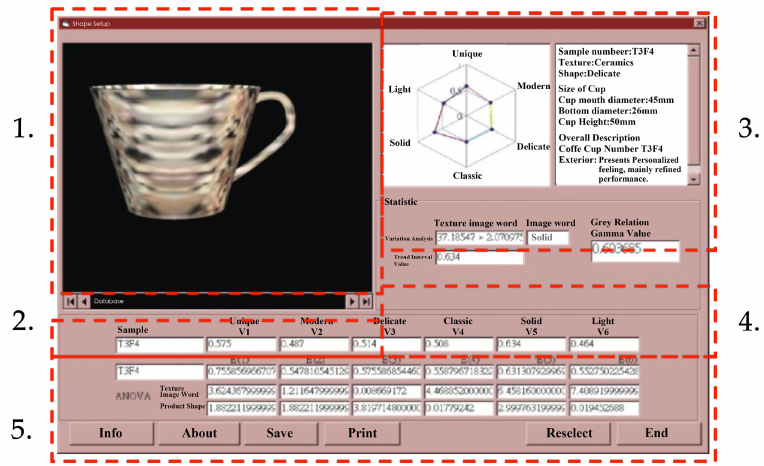
The Illustration Chart of Functional Sub-Areas of Master Program in Automatic Form System.